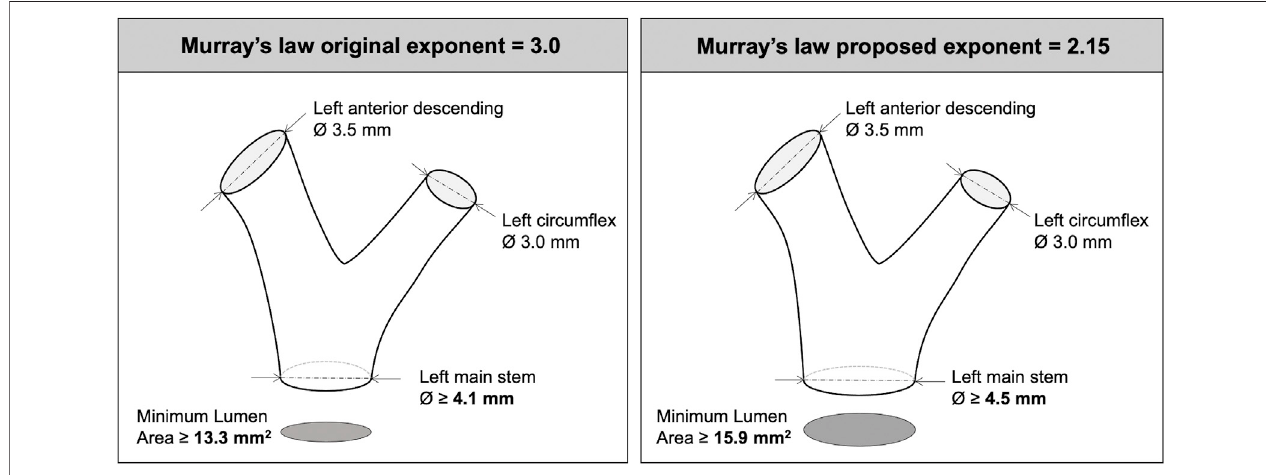
FIGURE 3 | Implications of Murray ’ s exponent when interpreting left main bifurcation anatomy and parent daughter branch scaling.